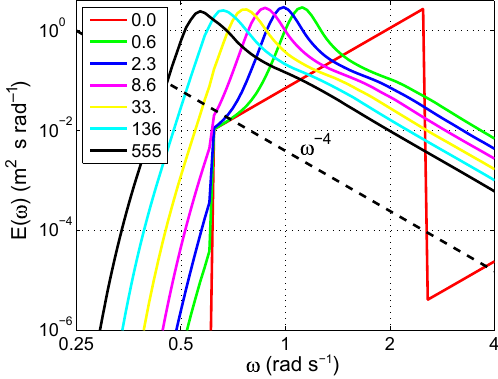
Figure 1. Frequency spectra of energy at different times (legend, in hours) for case sw330 ( (cid:50) = 330 ◦